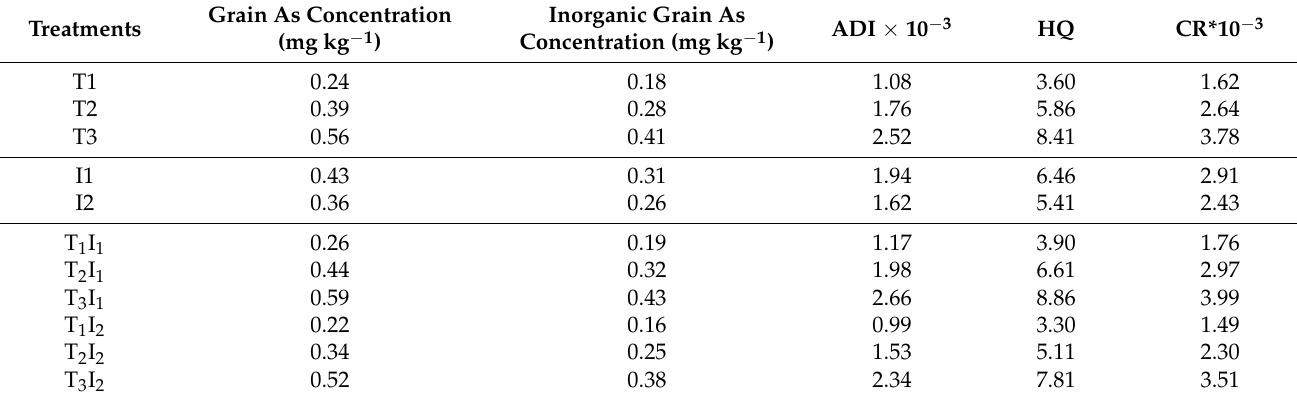
Table 5. Average daily intake of inorganic As from rice consumption and human health risk assessment. Grain As Treatments